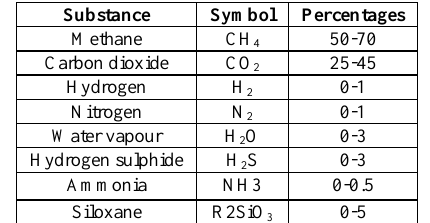
Table 1. Composition of